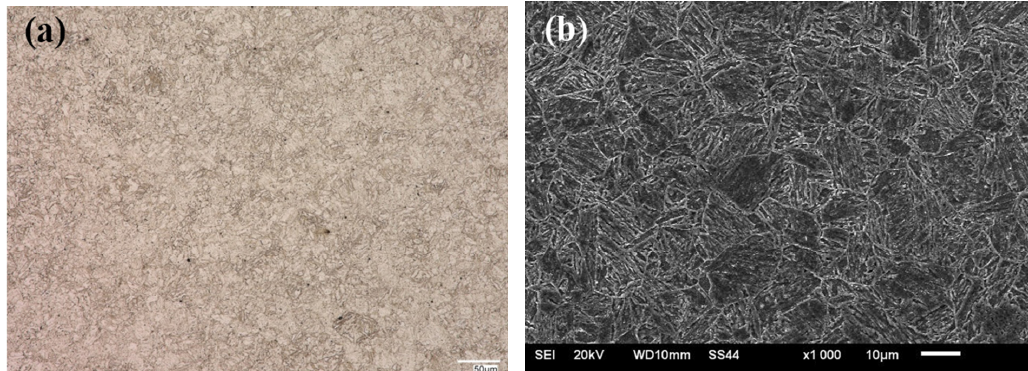
Figure 3. Hardness distribution on the cross-section of the welded joint.